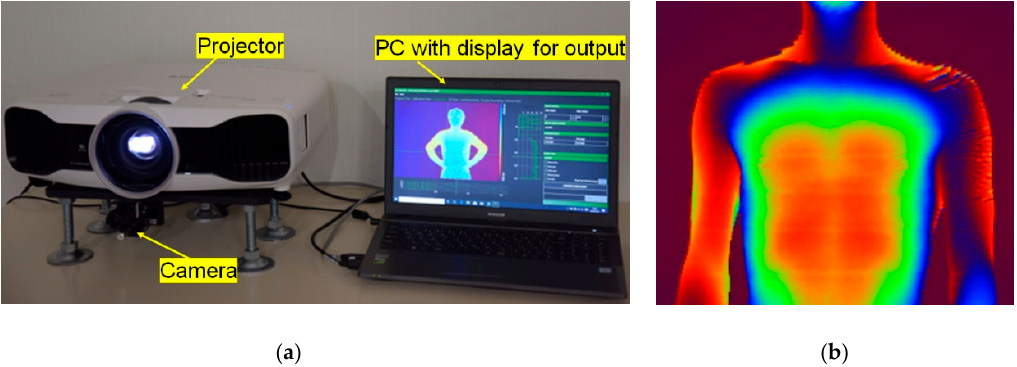
Figure 7. Real-time motion capture system and example of a measured human body. Real-time motion capture system and example of measured human body. (a) Real-time motion capture system (OPPA3); (b) Measured human body (OPPA1). One of the Supplementary Materials is a video of the OPPA Motion Capture.